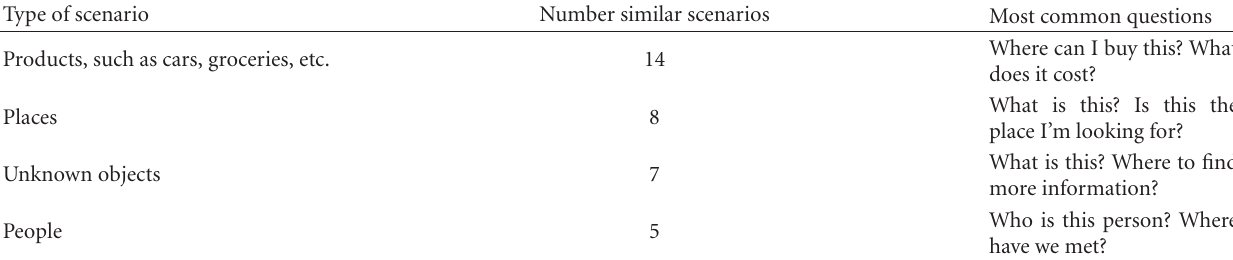
Table 1: Most frequent